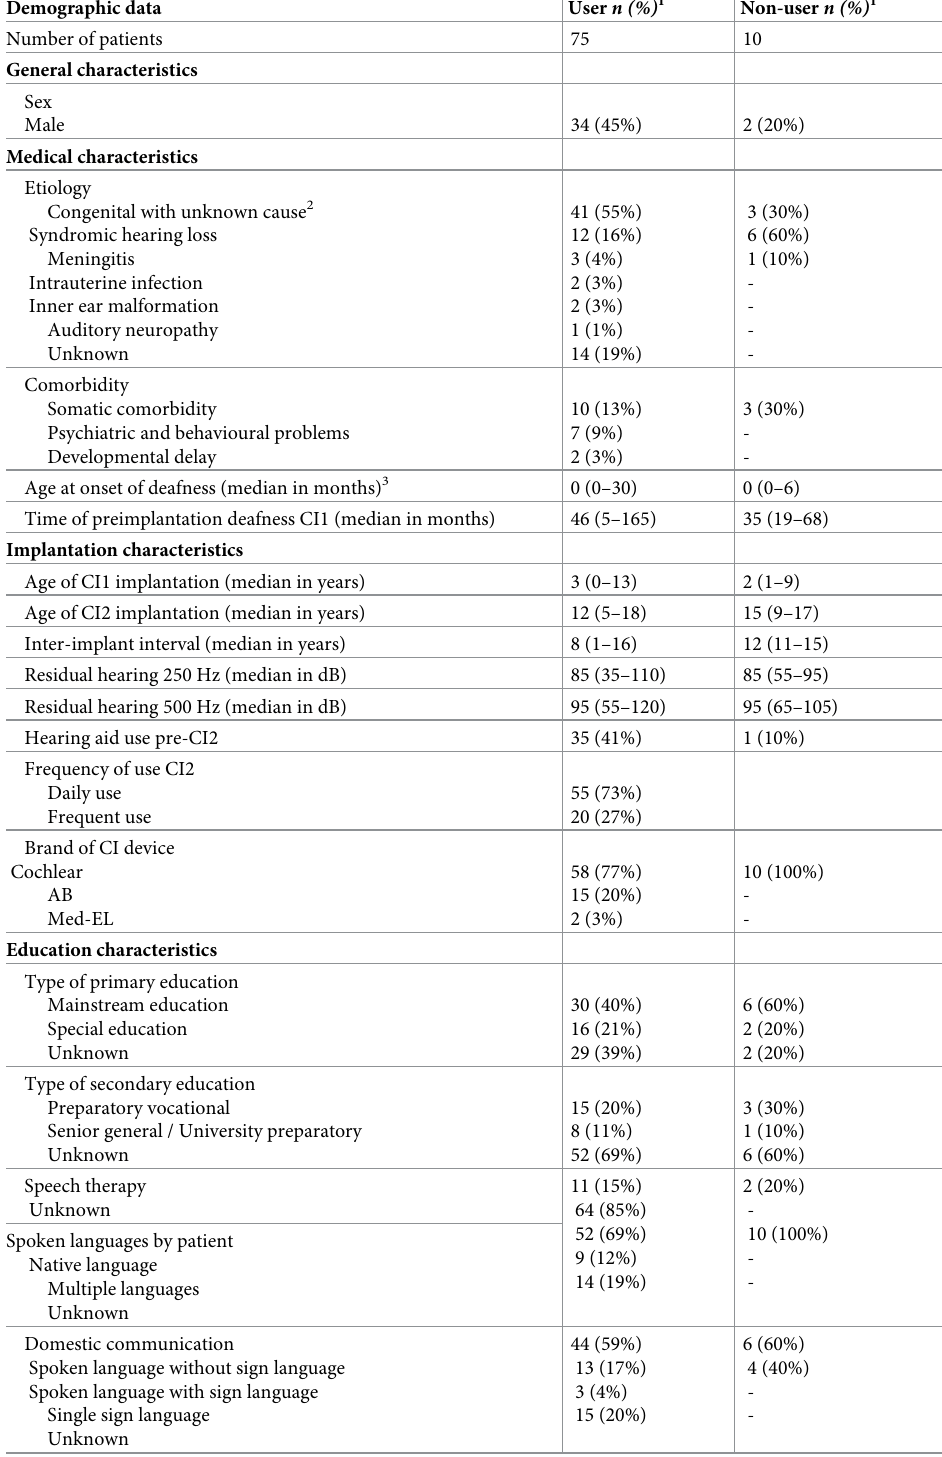
Table 1. Baseline